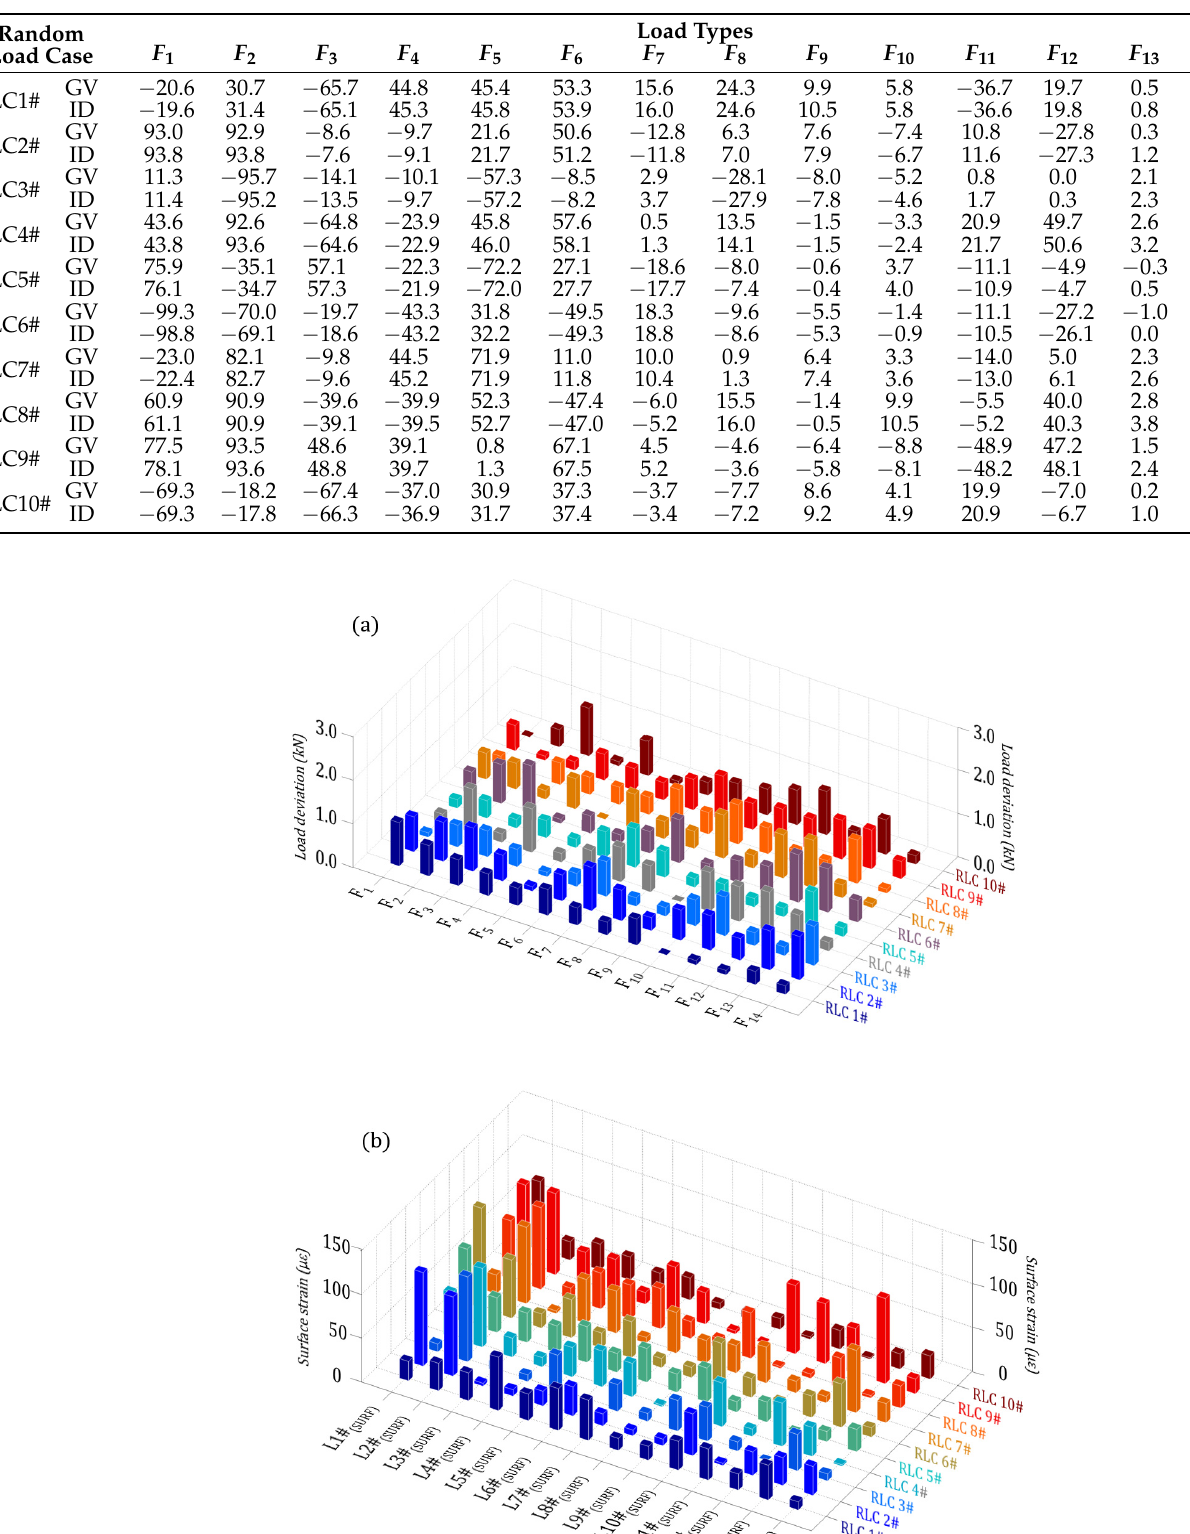
Table 5. Comparison between identified and given loads (kN).